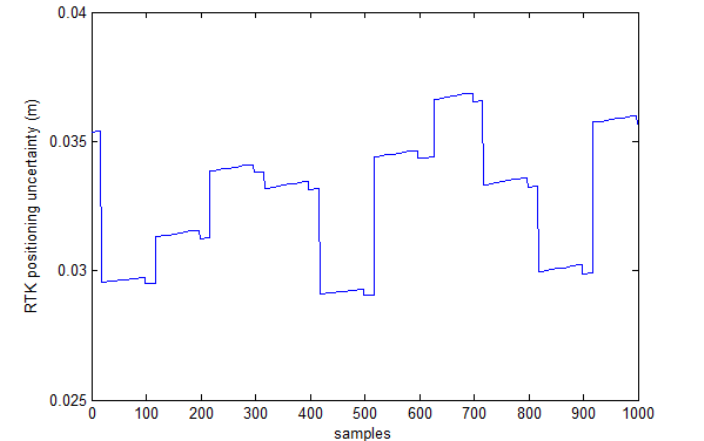
Figure 8. Auto-estimated uncertainty of target position estimation in a typical case.